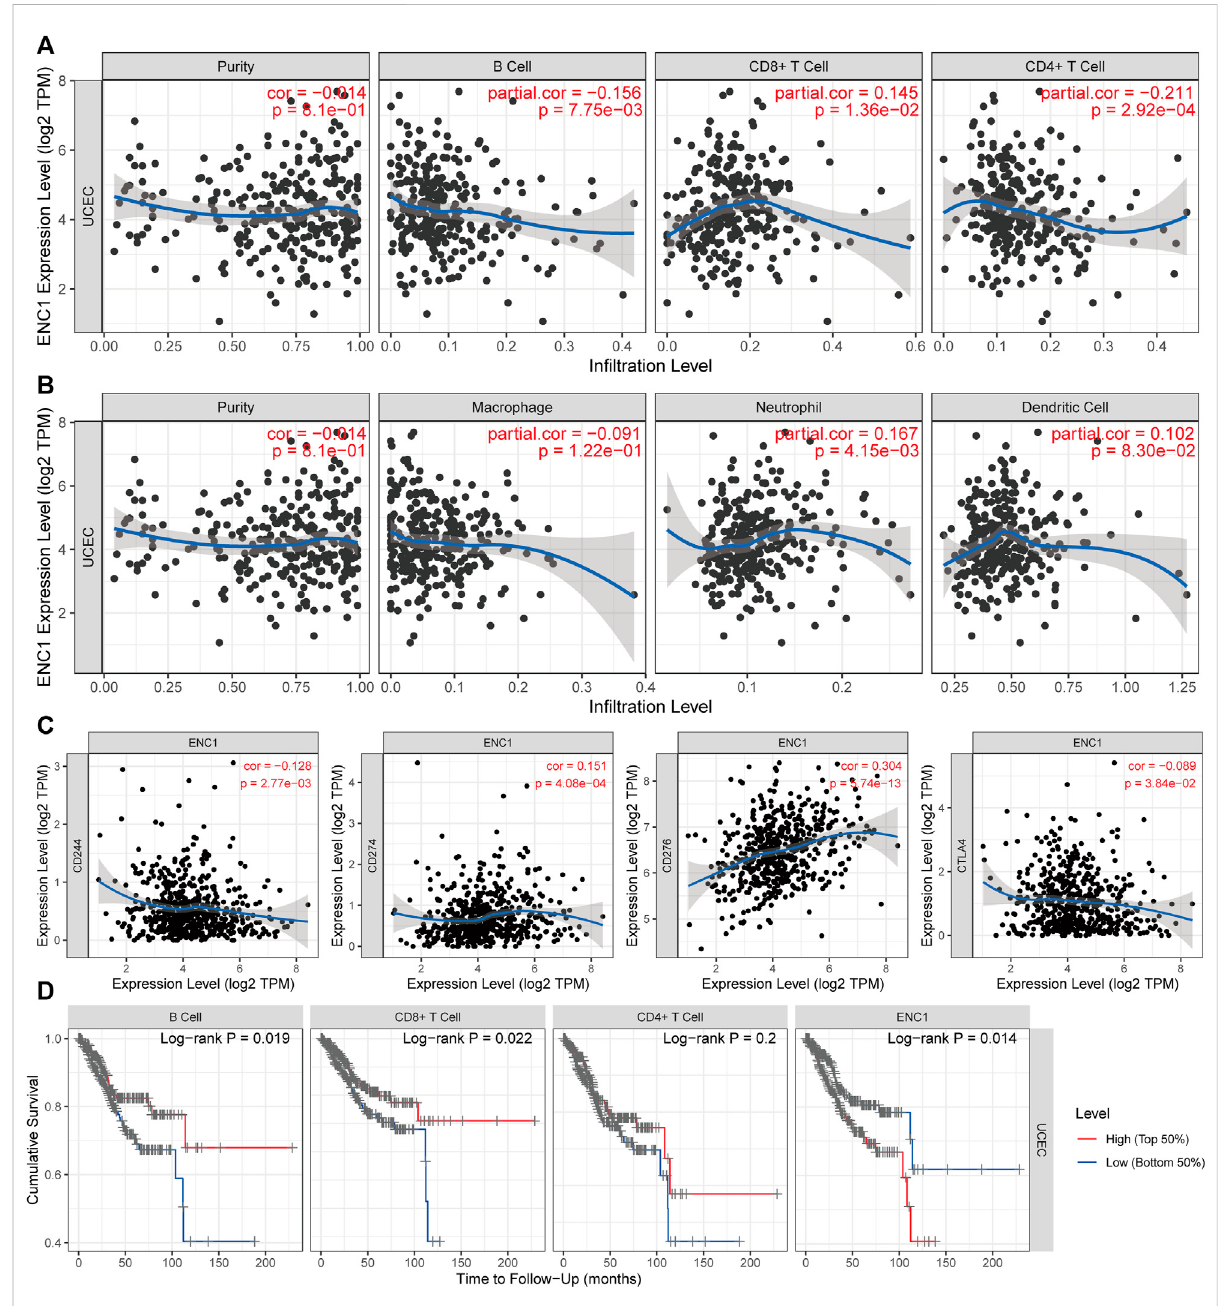
CD8 + cell in fi ltration had a better prognosis, and those with high ENC1 expression had a worse